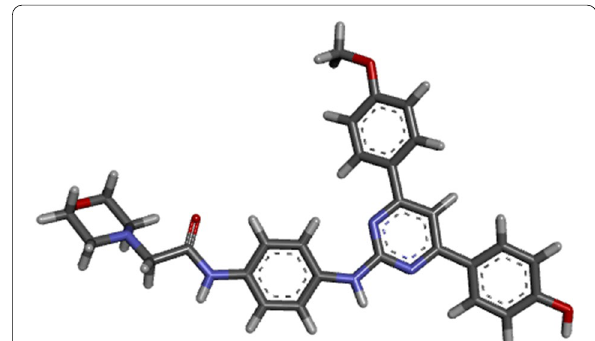
Fig. 5 3D Structure of stable conformation of compound 11 (Template)